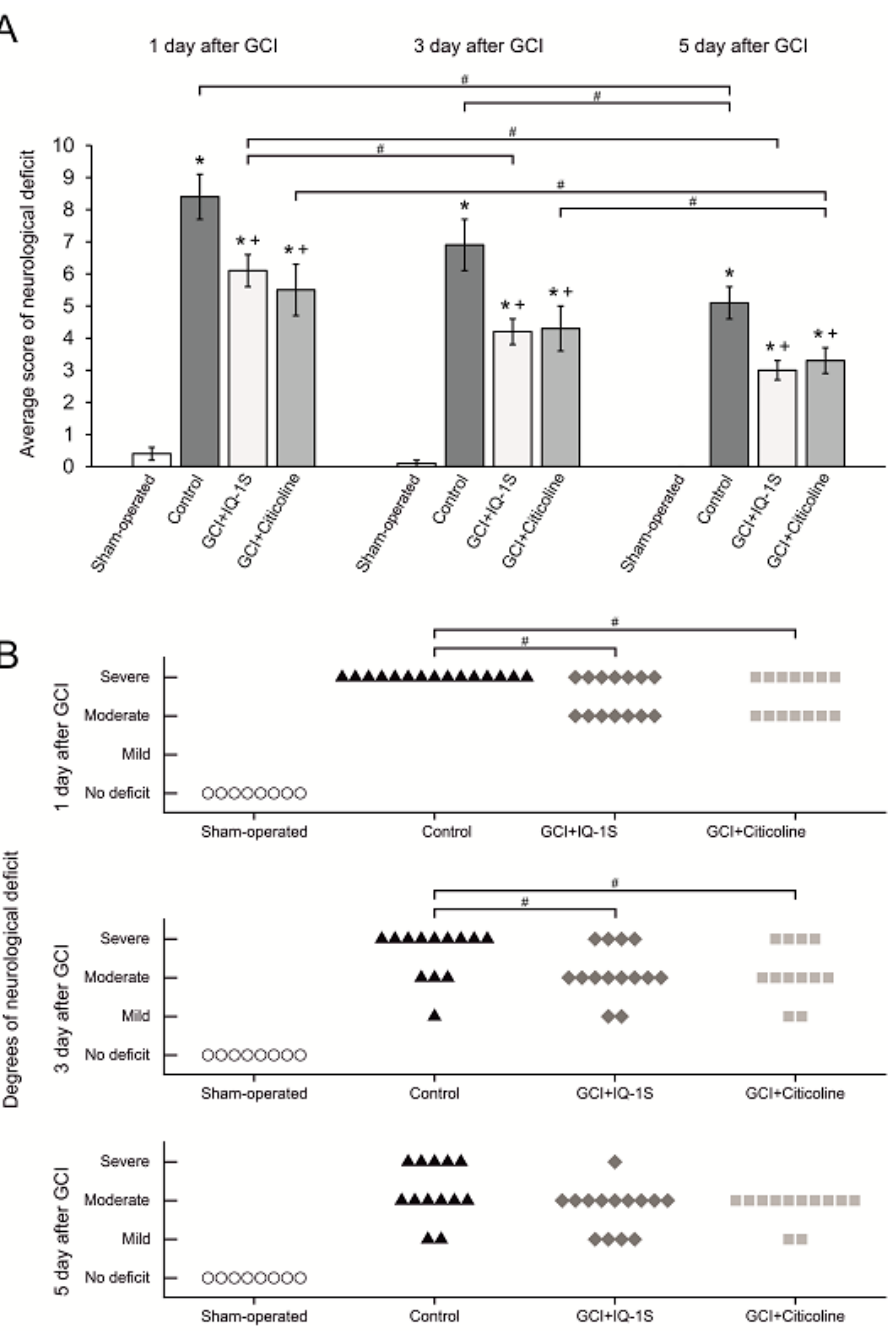
Figure 1. Effects of IQ-1S (50 mg/kg, i.g.) and citicoline (500 mg/kg, i.p.) on average score of neurological deficit ( A ) and animal distribution for degree of neurological deficit (severe, moderate, and mild) ( B ). * р < 0.05 as compared with the sham-operated animals; + р < 0.05 as compared with the control animals (A: # р < 0.05 at different times; B: # р < 0.05 for subgroups “severe” only).